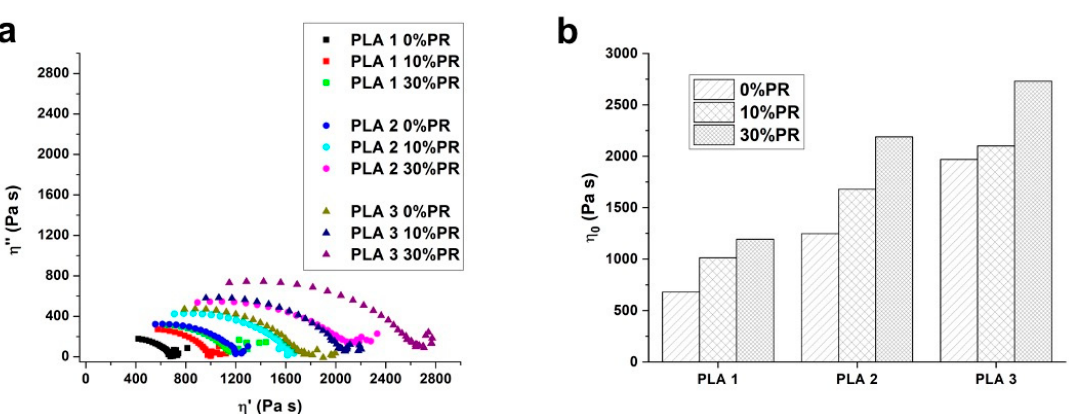
Figure 2. Cole–Cole plot ( a ) and Newtonian viscosity ( b ) for all the composites studied.